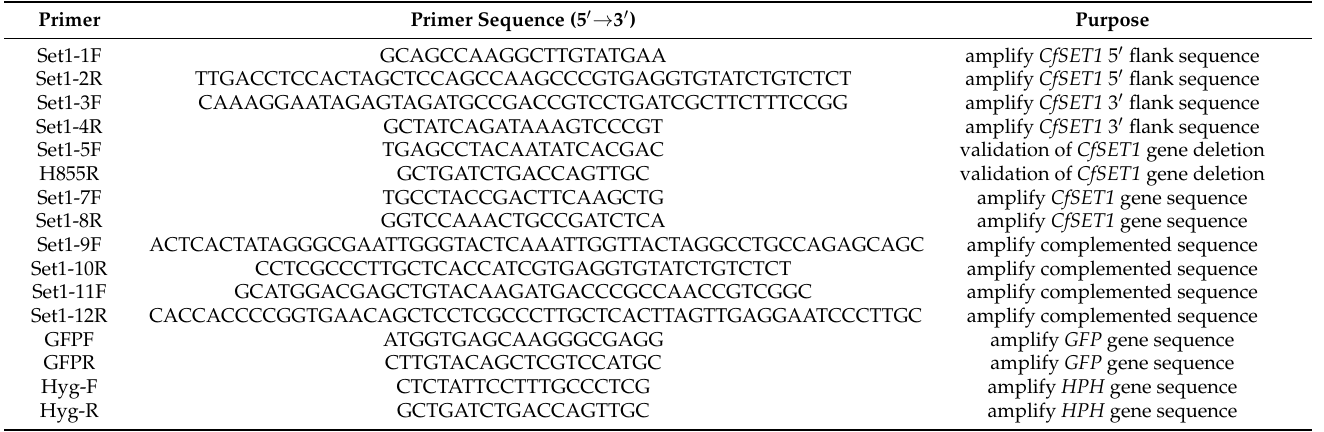
Table 1. Primers used in this study for amplifying related gene